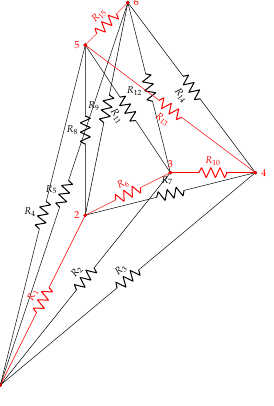
Figure 15. Path for delivering merchandise on the Xalapa map. Figure 16 shows two alternate full path resistive grid configurations using differ- ent starting nodes. In the case of the resistive grid on the left side, the starting node is the number three, which generates a connection tree formed by the resistors in red { R } and a path sequence { 3, 4, 2, 1, 5, 6 } . On the other hand, the resistive 10 , R 7 , R 1 , R 4 , R 15 grid on the right side starts at node five generating a connection tree compound of the resistors in red { R 15 , R 12 , R 10 , R 7 , R 1 } and a path sequence { 5, 6, 3, 4, 2, 1 } . Moreover, the to- tal lengths of each path shown on the left-side and right-side (Figure 16) are 8.62 km and 7.17 km,